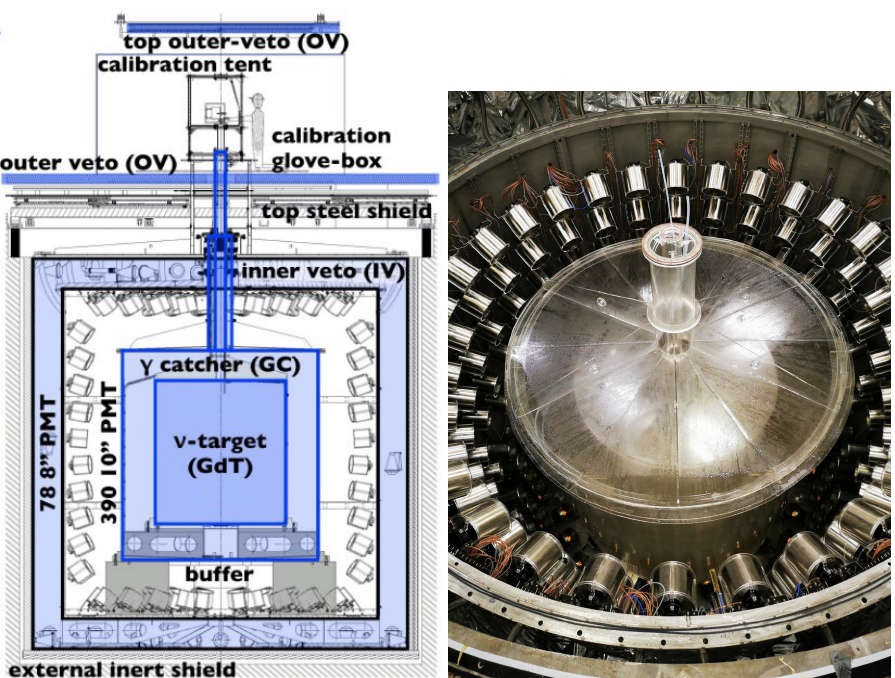
Figure 1. ( Left ): A cross-sectional view of one of the two identical detectors of Double Chooz. ( Right ): A picture of the near inner detector where the target and GC acrylic vessels and the photo-multipliers (with their individual magnetic shielding) are